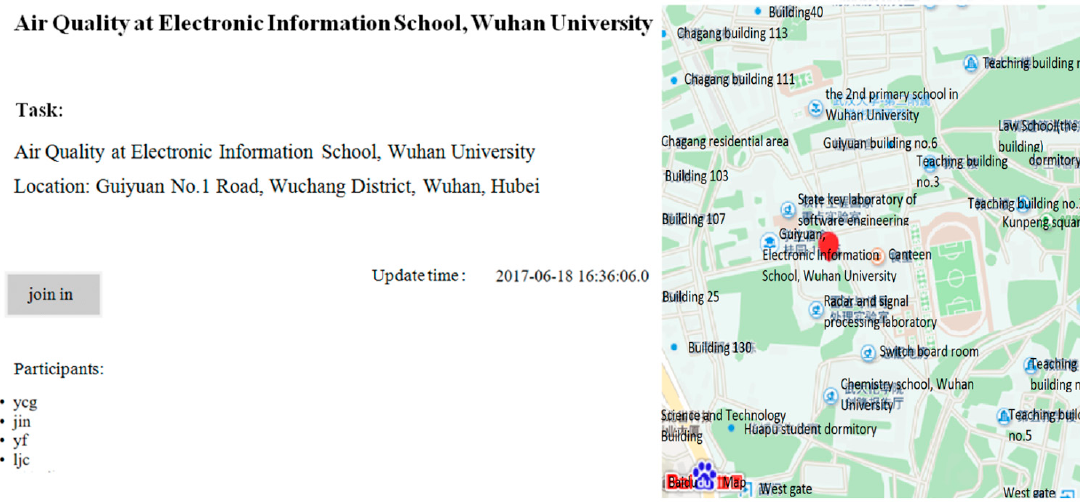
Figure 3. The screenshot of air sensing platform webpage.